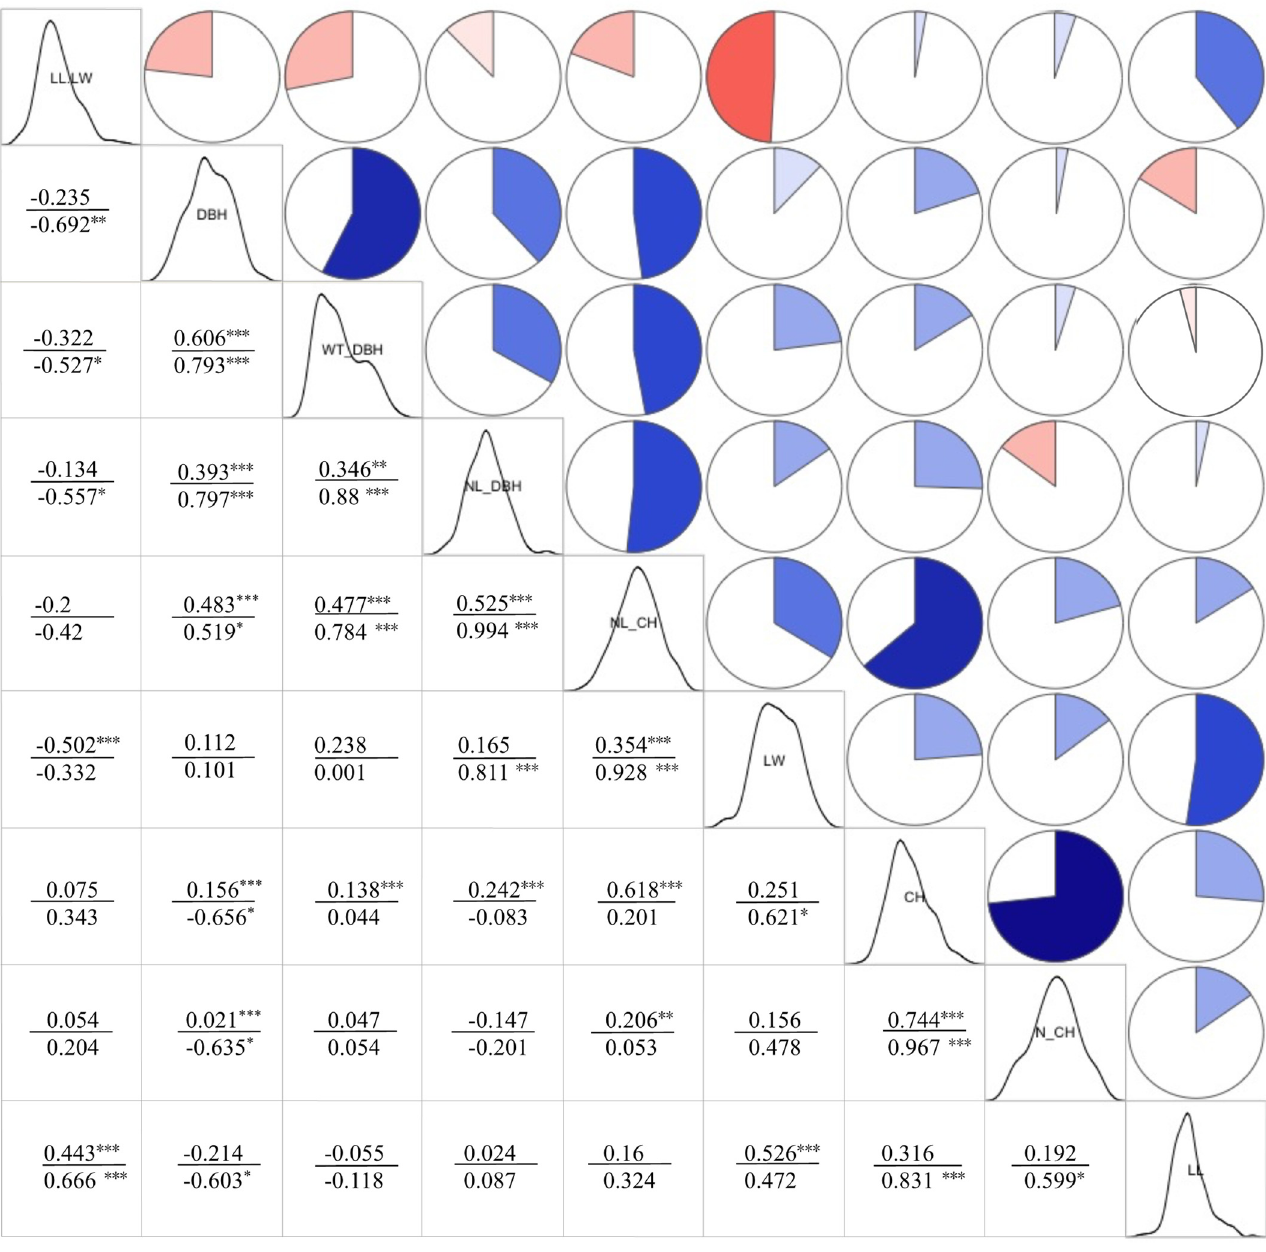
Figure 3. Correlation analysis of 9 phenotypic traits in Moso bamboo ( Phyllostachys edulis ). Notes: